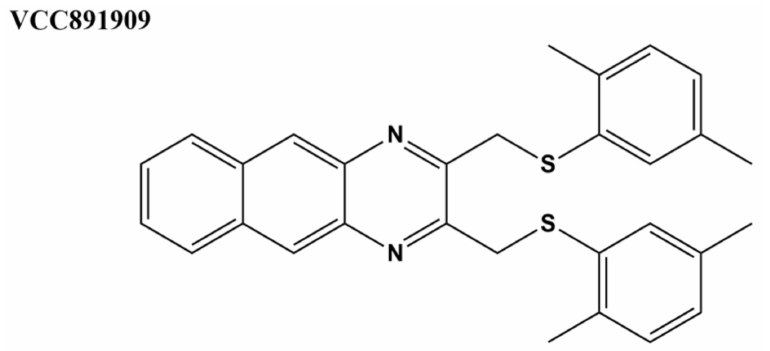
Figure 7. VCC891909 from Vichem’s Nested Chemical Library (NCL)